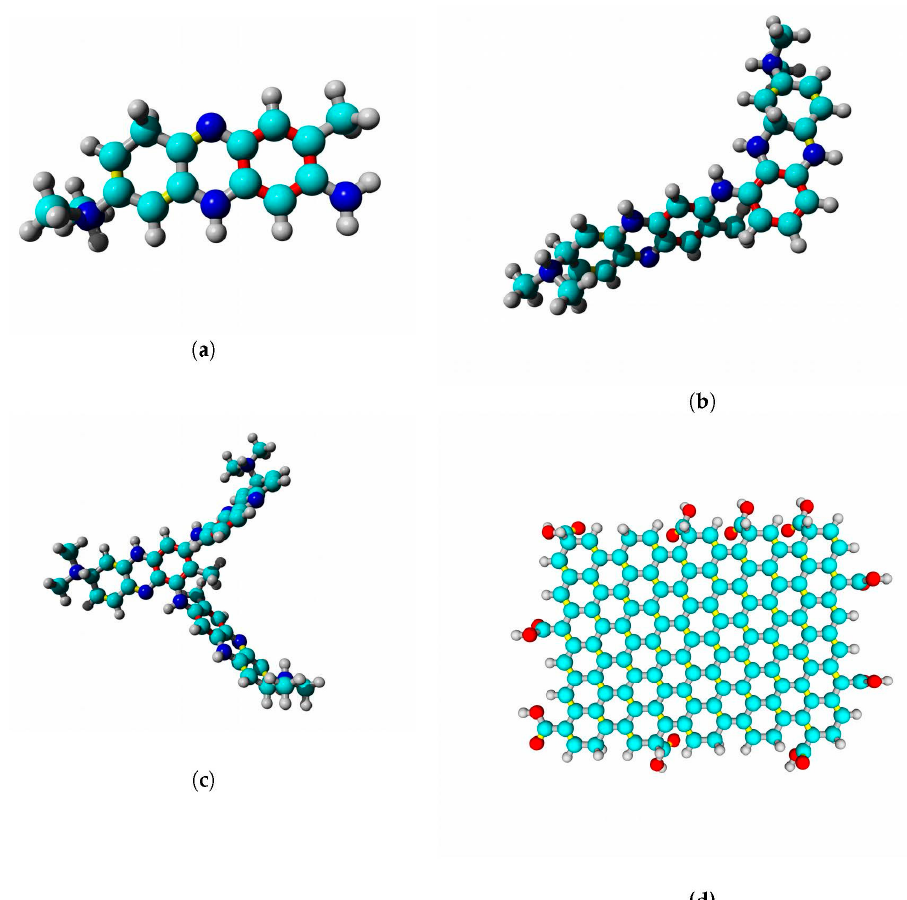
Figure 14. Substances used in molecular docking: ( a ) neutral red monomer; ( b ) neutral red dimer; ( c ) neutral red trimer; and ( d ) graphene oxide. Carbon is colored cyan, nitrogen is blue, oxygen is red, and hydrogen is gray. Single bonds are gray, double bonds are yellow, and resonance bonds (order 1.5) are red.